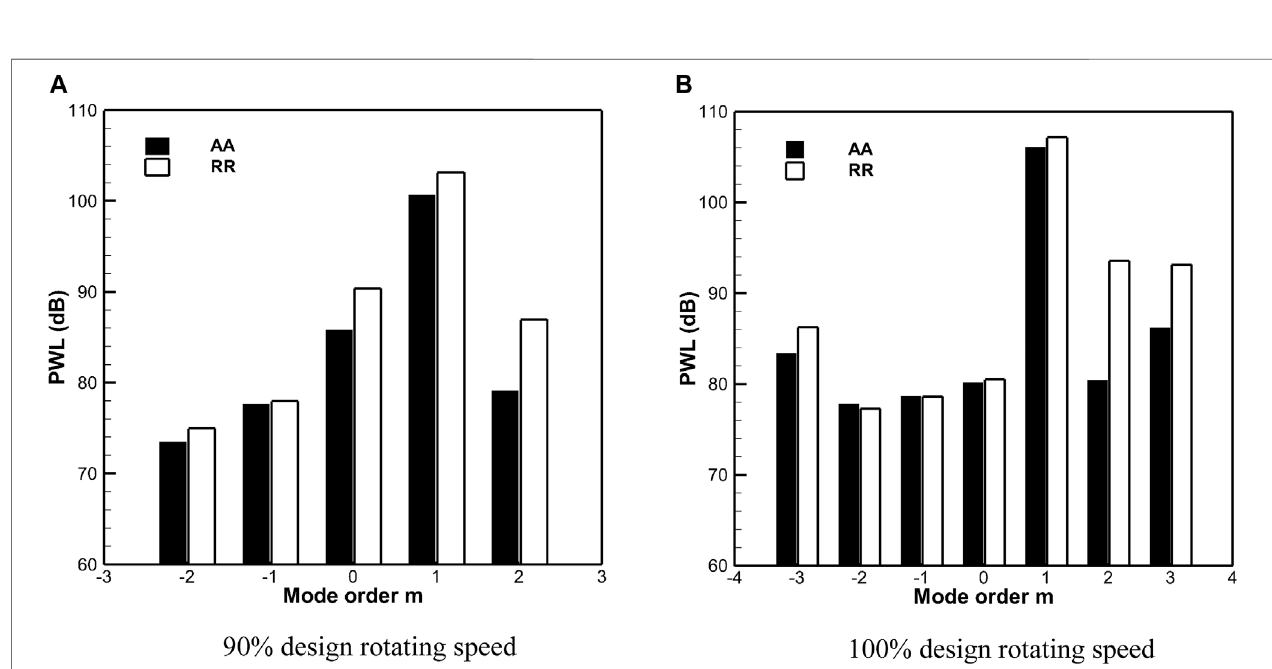
FIGURE 15 | Comparison of modal sound power applying radial rakes and axial microphone arrays. (A) 90% design rotating speed. (B) 100% design rotating speed.